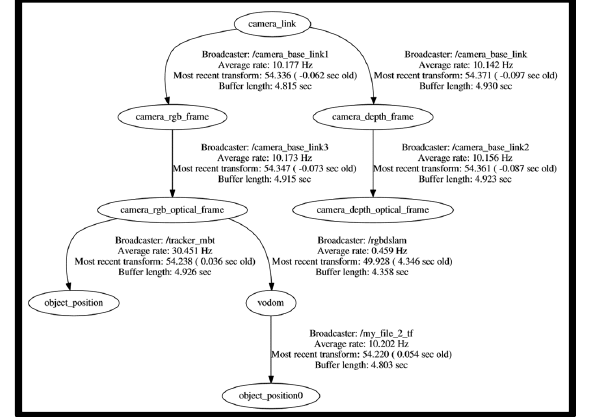
Figure 8. ViSP / RGB-D SLAM tree of coordinate transforms output from ROS’s tf/view_frames